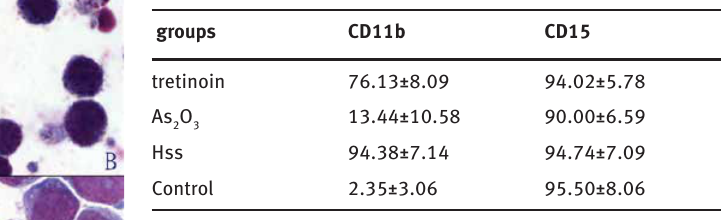
Table 4: The change of HL-60 cell cycle after 72 hours’